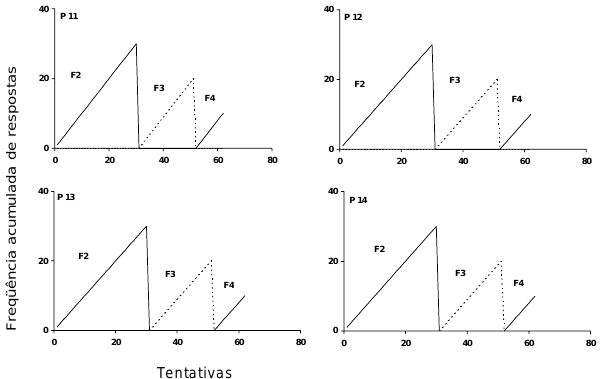
Figura 1 . Freqüência acumulada de respostas corretas (linha sólida) e incorretas (linha tracejada), para cada participante (P) da Condição 1, durante as Fases (F) 2, 3 e 4. Quebras na curva acumulada indicam mu- danças de fase.